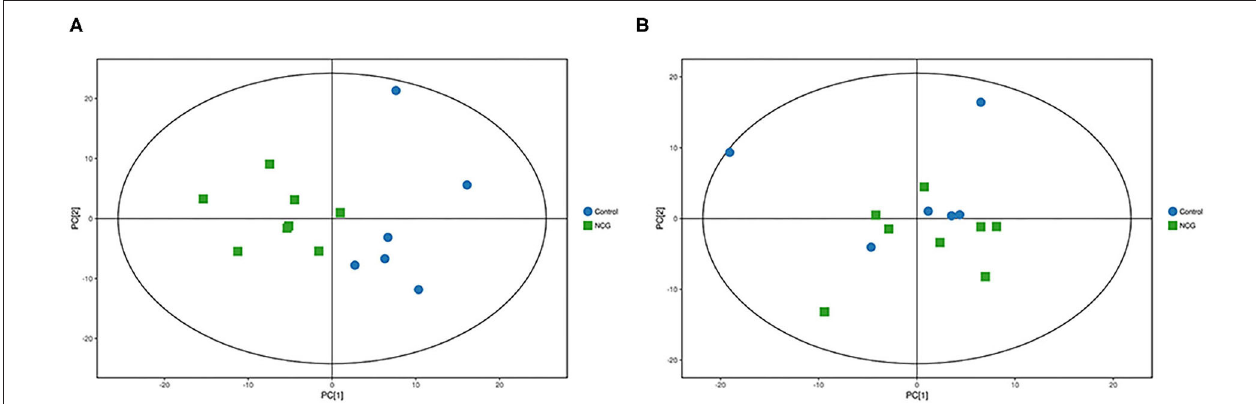
FIGURE 4 | (A) Principal component analysis score plot for the NCG group and CON group feces samples analyzed in the positive ion mode. (B) Principal component analysis score plot for the NCG and CON group samples analyzed in the negative ion mode. The abscissa PC[1] = first principal component and the ordinate PC[2] = second principal component. The blue circle represents the CON group, and the green square represents the NCG group. The samples are all in within the 95% confidence interval (Hotelling’s T-squared ellipse). The blue circle represents the diet without NCG supplementation (Control, CON group, N = 6), and the green box represents the experimental group with 20 (g/d/head) NCG added to the diet (NCG, NCG group, N = 8).